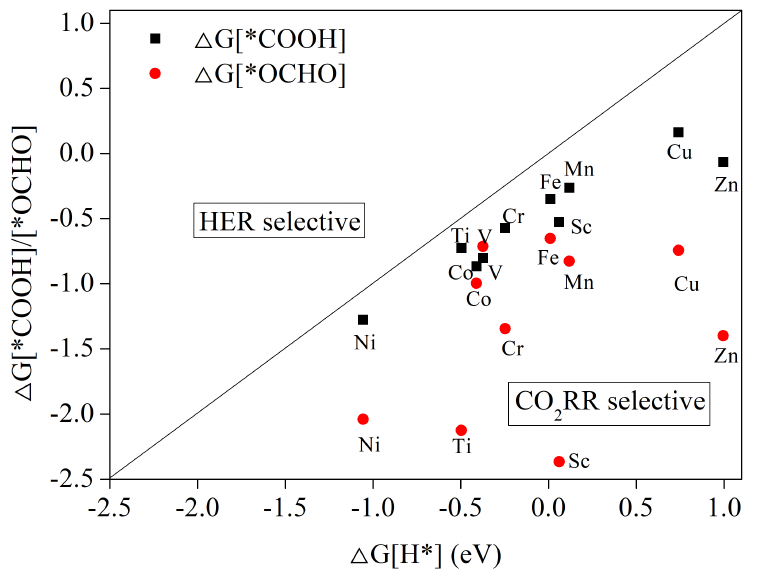
Figure 3. The Gibbs free energy change of the first protonation step in the CO 2 reduction reaction (CO 2 RR) and H 2 evolution reaction (HER). CO 2 RR selective catalysts are those located below the dotted